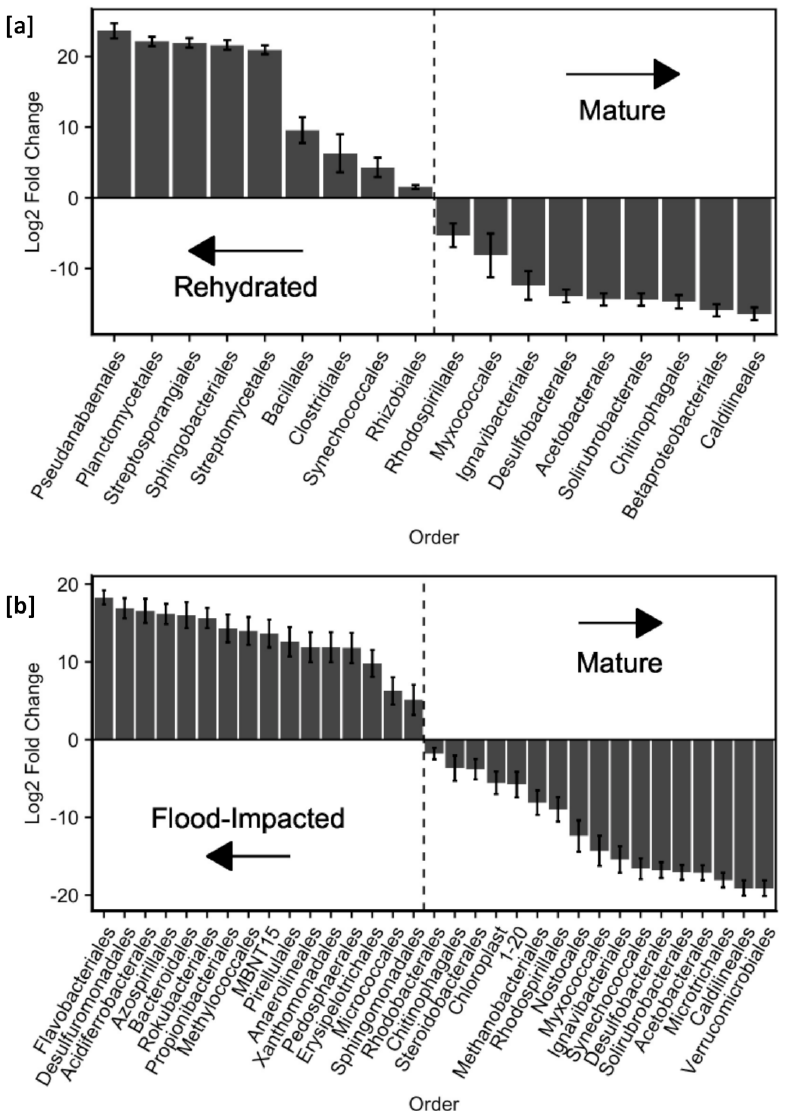
Figure 6. The Log2FoldChange illustrates the orders that have undergone the largest change during desiccation/rehydrated ( a ) and flooding ( b ). Both figures illustrate the impact of each disruption, suggesting a degradation of geochemical and redox stratification due to either desiccation and/or the energy of the